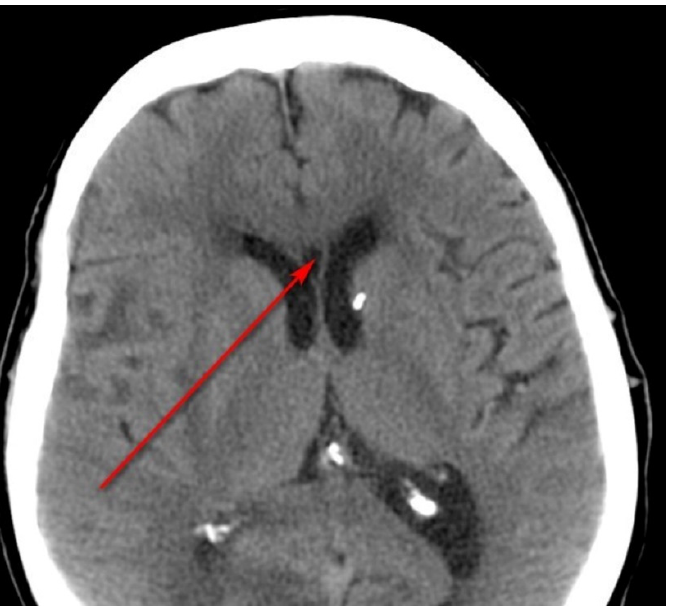
Figure 3. Computed tomography scan of the head of patient No. 62, a 55-year-old female. The arrowhead shows the cavum septi pellucidi (CPS).